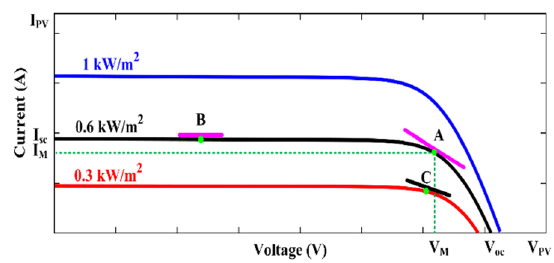
Fig. 6 I-V characteristics with changing R i superimposed over the